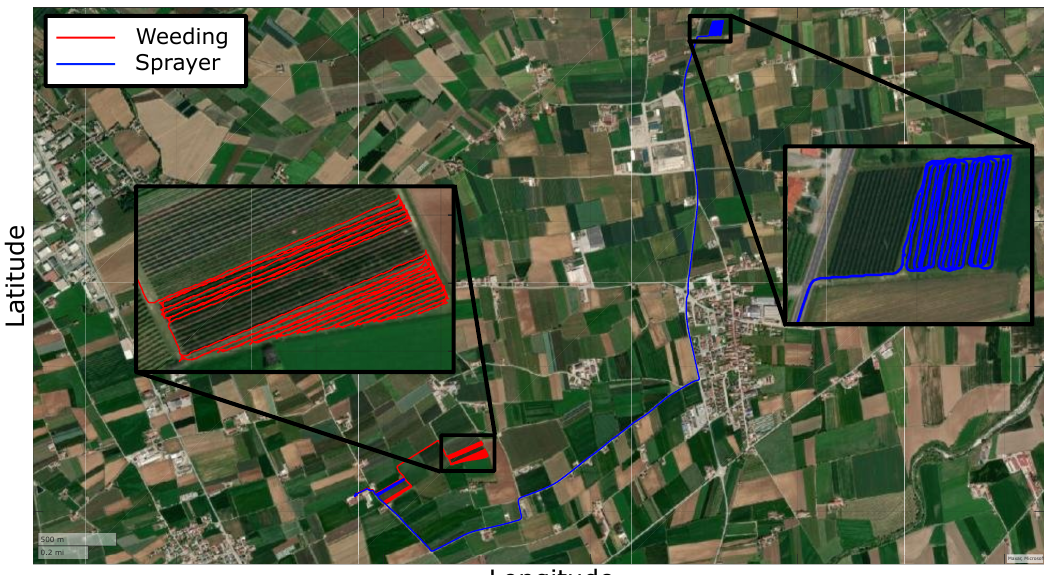
Figure 6. GPS Experimental data for the work cycles.